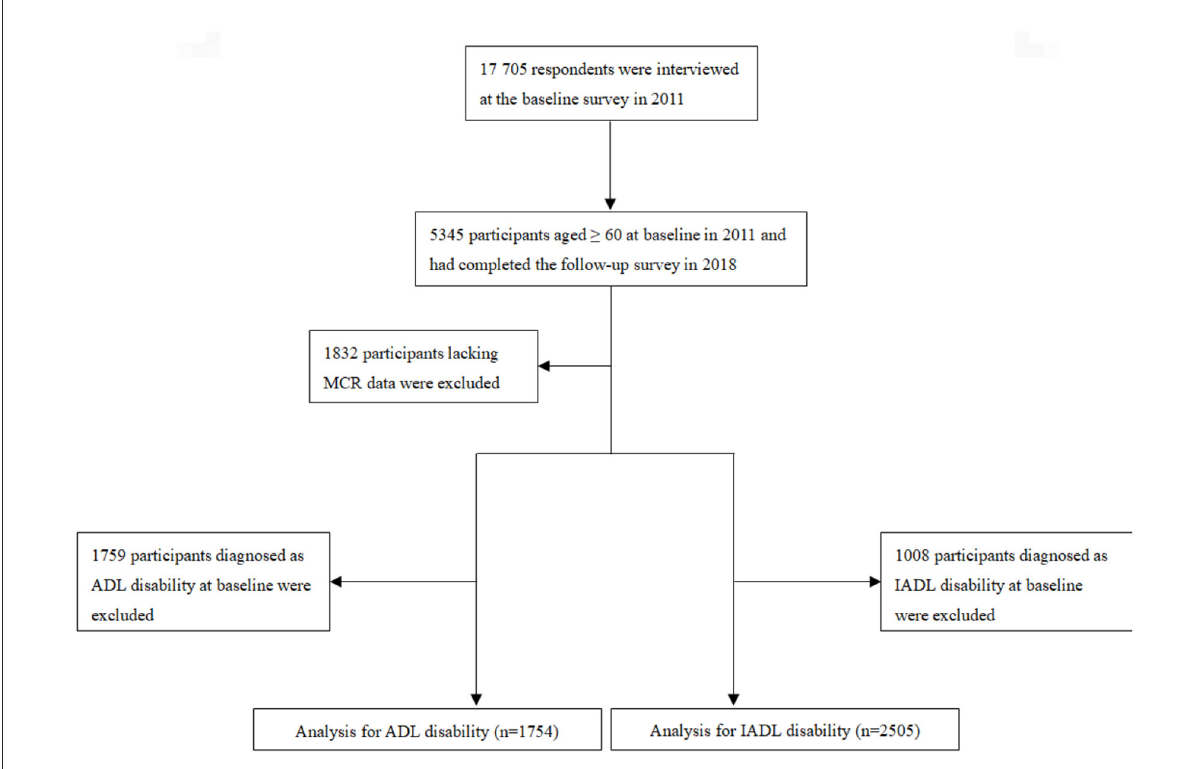
FIGURE1 Flowchart of the study identification